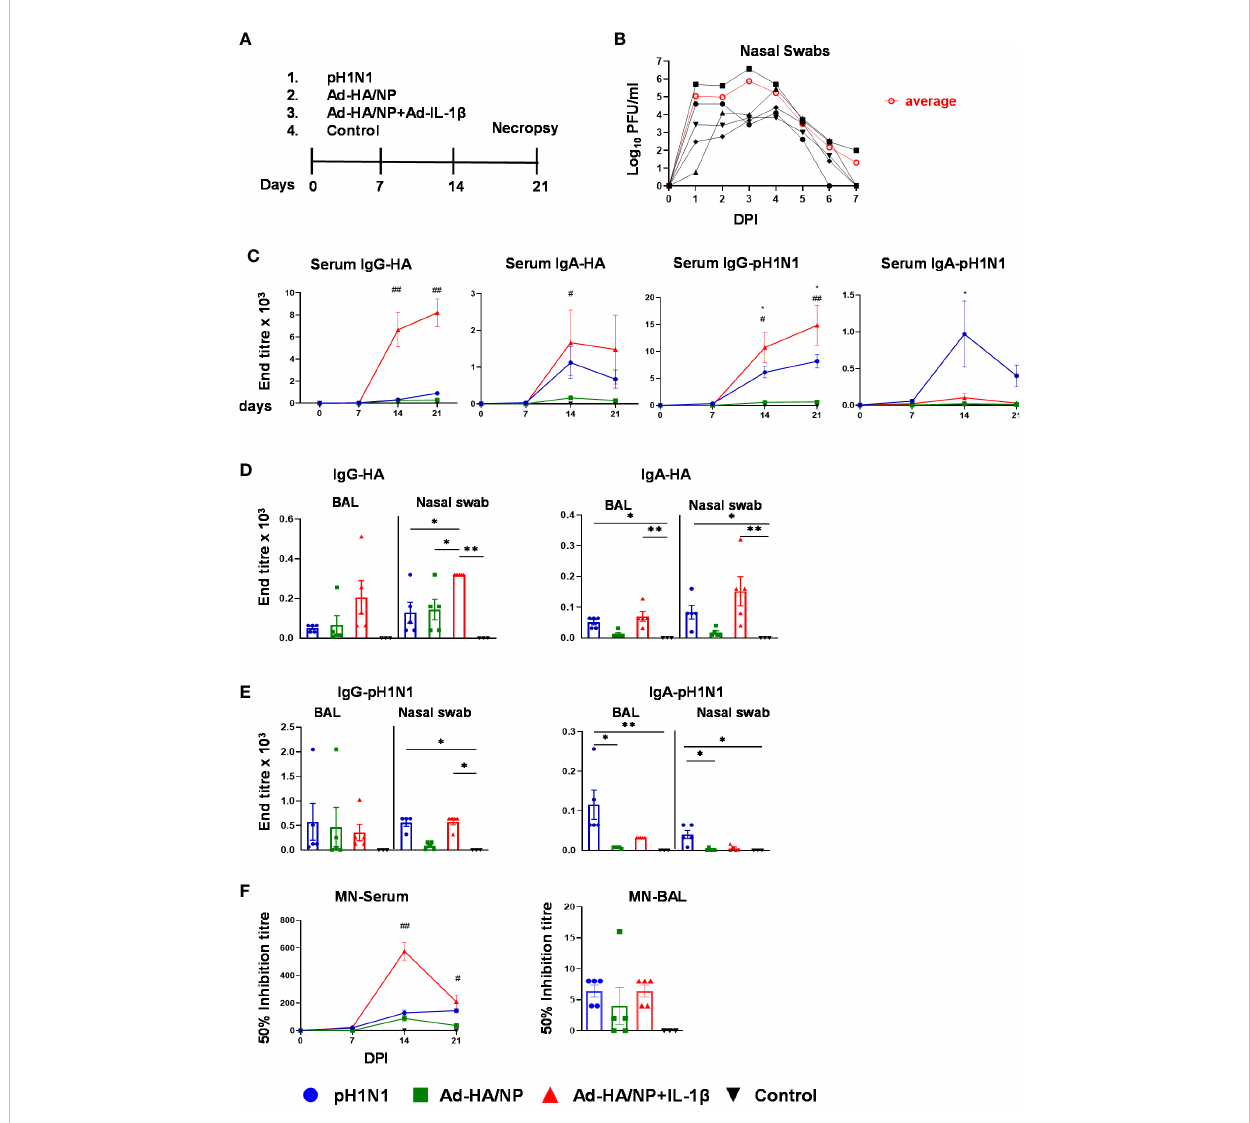
FIGURE 1 Experimental design, viral load, and systemic as well as mucosal antibody responses. (A) Babraham pigs ( fi ve per group) were either intranasally infected with the pH1N1 virus or immunized with Ad-HA/NP or Ad-HA/NP+Ad-IL-1 b . Control animals were given PBS intranasally (three pigs). Nasal swabs were collected daily for seven days. Weekly blood samples were collected. All animals were humanely culled on day 21 post-infection or immunization. (B) Virus load in nasal swabs, taken daily after challenge, were assessed by plaque assay. Black lines represent the viral load in individual pigs and the red line indicates the mean viral load of the fi ve animals in the pH1N1 group. (C) HA- and pH1N1-speci fi c IgG and IgA responses in serum were determined by ELISA at the indicated time points. The mean ± SEM of fi ve or three (control) pigs per group are shown at the indicated points. (D, E) HA- and pH1N1-speci fi c IgG and IgA responses in BAL and nasal swabs were analyzed by ELISA at day 21 post-infection or immunization only. Each symbol represents an individual animal, the top of the bar the mean, and the line the standard error (SEM). (F) Functional antibody responses against pH1N1 were assessed in BAL at day 21 and in serum over time by microneutralization assay. For serum, the mean ± SEM of fi ve or three (control) pigs per group are shown. For BAL each symbol represents an individual animal, the top of the bar the mean, and the line the standard error (SEM). (MN). (C – F) Statistical signi fi cances were analyzed for serum by two-way ANOVA followed by Tukey ’ s Multiple Comparison Test. One-way ANOVA was used for IgG-HA (BAL and nasal swabs) and Kruskal – Wallis test with Dunn ’ s multiple comparisons test was used for